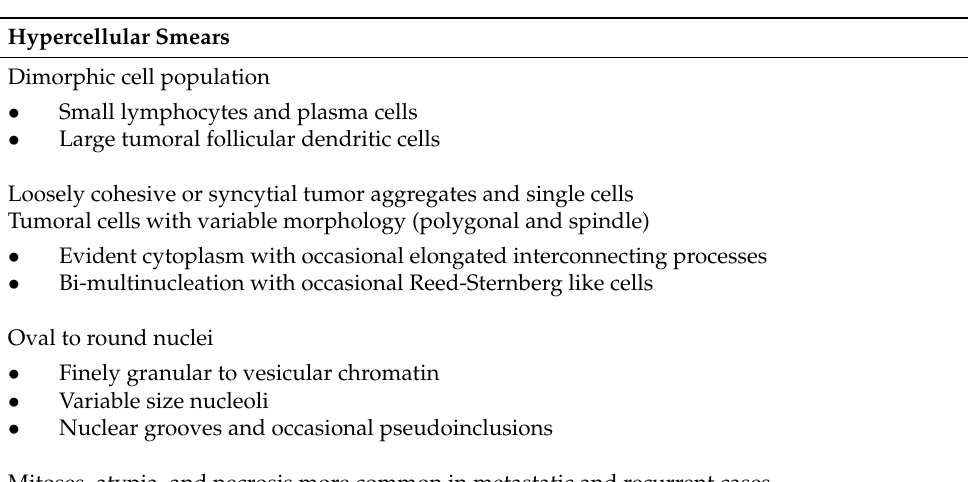
Table 2. Main cytological features of follicular dendritic cell